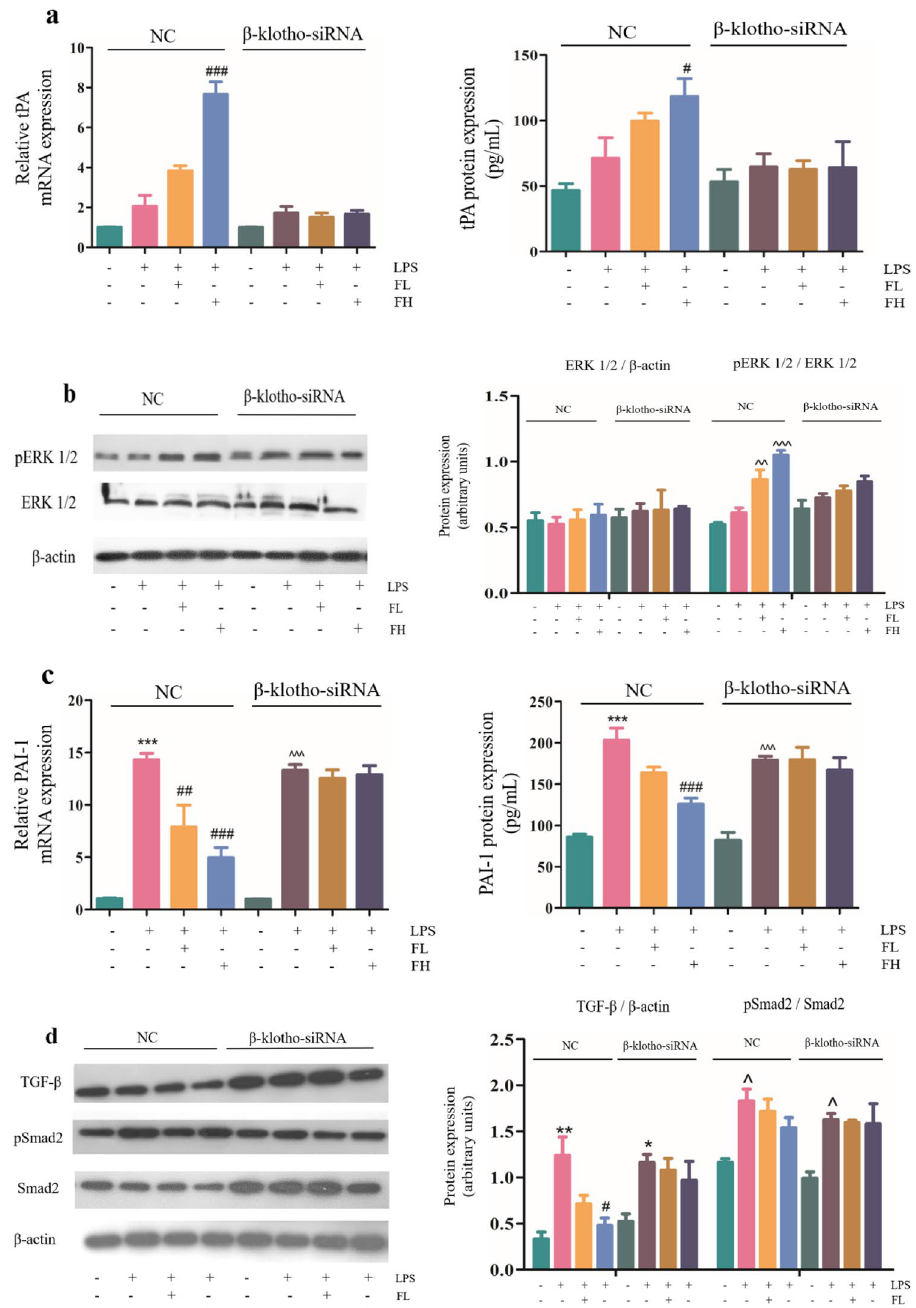
Figure 6. FGF-21 promotes tPA expression and inhibits PAI-1 expression in EA.hy926 cells. β-klotho-siRNA or NC siRNA was transiently transfected into EA.hy926 cells using Lipofectamine 3000 transfection reagent. Cells were treated with LPS (1000 μg/mL) with or without FGF-21 (FL: FGF-21 0.1 M, FH: FGF-21 1.0 M). tPA: tissue plasminogen activator; PAI-1: Plasminogen activator inhibitor 1; NC: nontransfection. ( a ) Analysis of tPA expression by real-time PCR and ELISA in EA.hy926 cells. ( b ) Western blot analysis of ERK1/2 phosphorylation levels in EA.hy926 cells. ( c ) Analysis of PAI-1 expression by real-time PCR and ELISA in EA.hy926 cells. ( d ) Western blot analysis of Smad2 phosphorylation levels and TGF-β expression in EA.hy926 cells. For all bar graphs, data are expressed as the mean±SD (n = 3). One-way ANOVA was used for multiple group comparisons, followed by Student’s two-tailed t test. * p < 0.05, ** p < 0.01, *** p < 0.001 compared with the control NC group; # P < 0.05, ## P < 0.01, ### P < 0.001 compared with the model NC group; ^ P < 0.05, ^^ P < 0.01, ^^^ P < 0.001 compared with the control β-klotho-siRNA